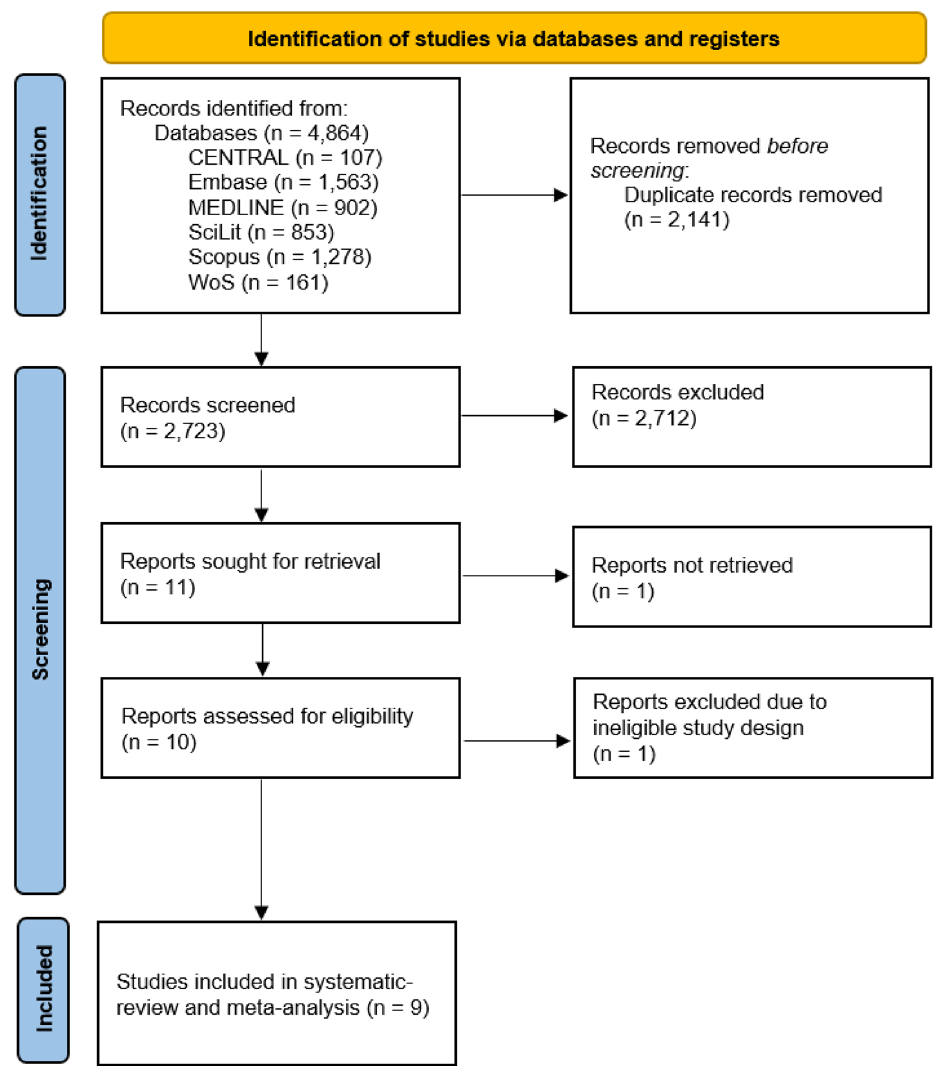
Figure 1. PRISMA flowchart. CENTRAL Cochrane Central Register of Controlled Trials, WoS Web of